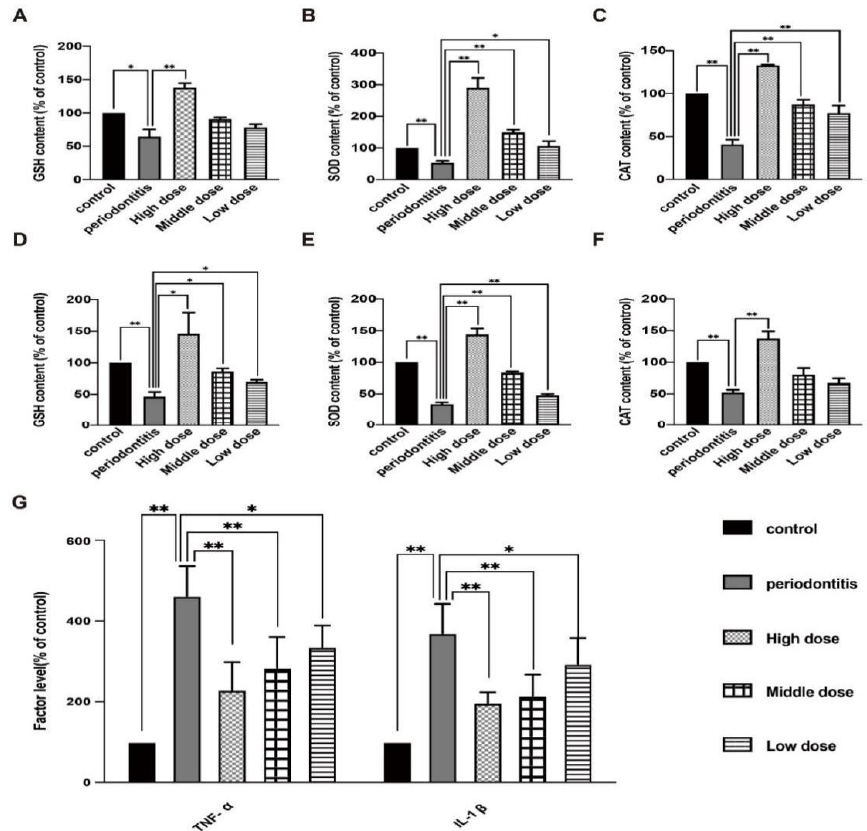
Figure 4. Effect of DhHP-6 on the antioxidant level and inflammation levels in rats. ( A – C ) Expression levels of SOD, GSH, and CAT in rat serum. ( D – F ) Expression levels of GSH, SOD, and CAT in rat gingival tissues. ( G ) Levels of the inflammatory factors TNF- α and IL-1 β in rat serum. * p < 0.05, ** p <